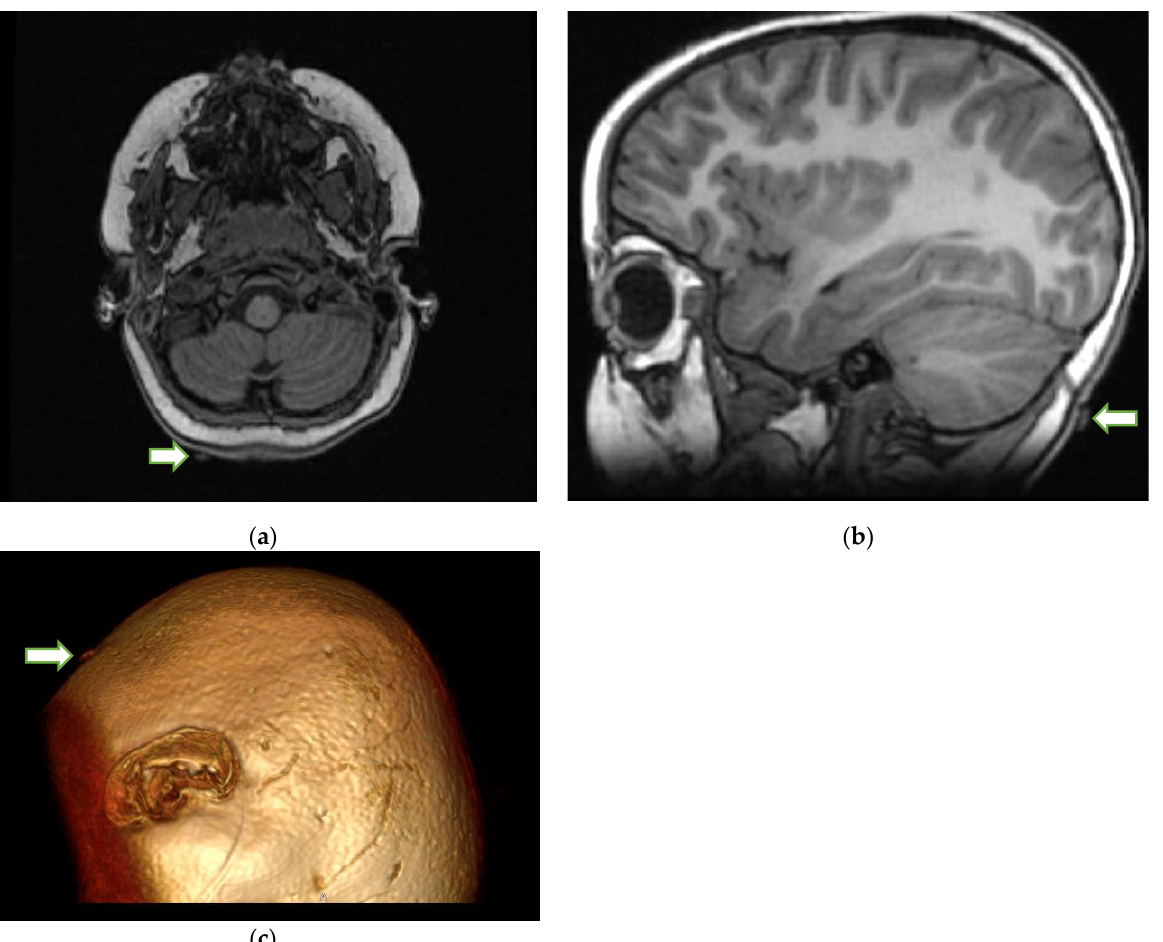
Figure 2. Axial T1-weighted ( a ) MRI of the brain at the level of the medulla shows a normal appearance of the medulla and the cerebellum. However, on closer inspection, there is a small, isointense area (arrow) seen attached to the skin in the occipital region on the right side. The arrow on the sagittal T1-weighted MRI of the brain ( b ) also points to the tick. The 3D rendering of the MRI ( c ) shows what appears to be a tick (arrow) on the surface of the head.